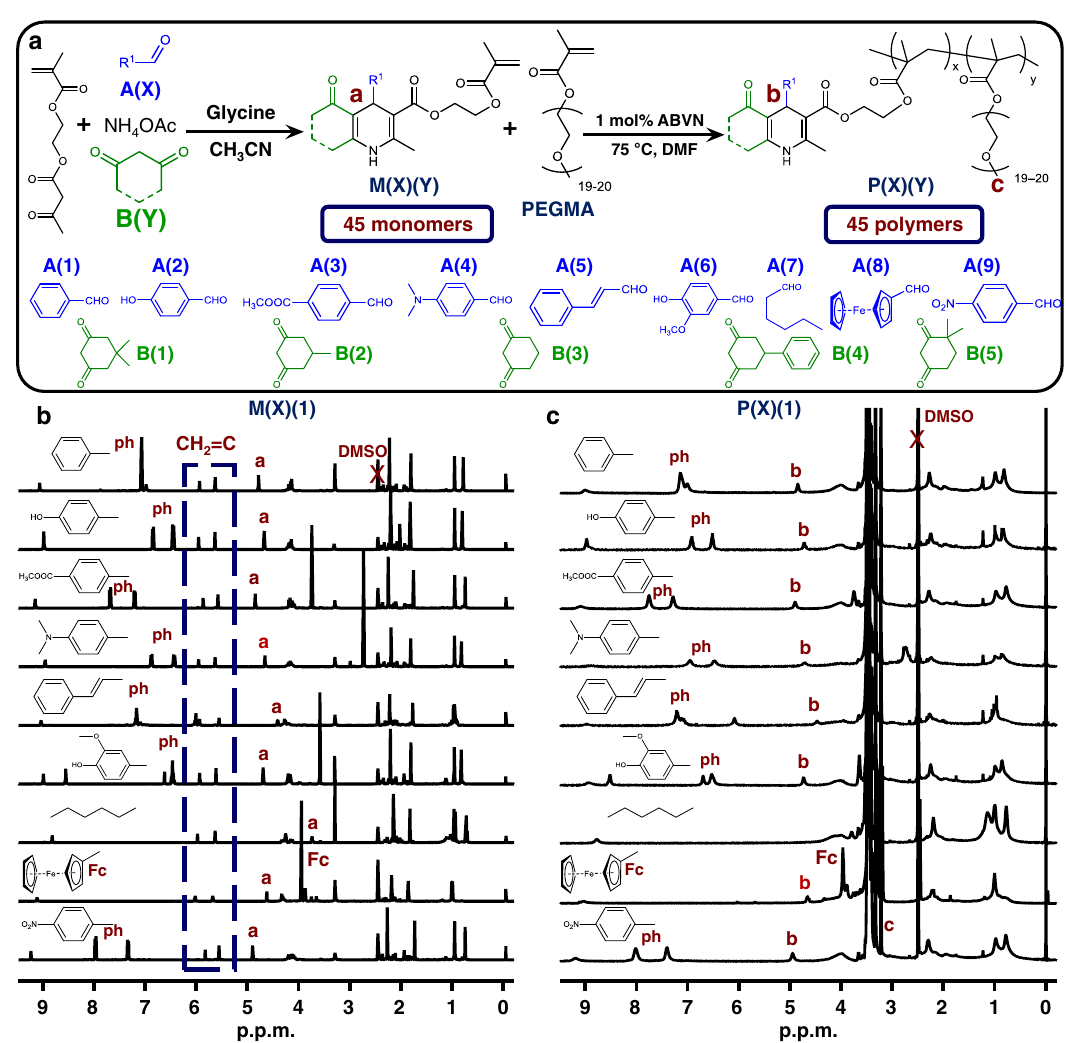
Fig. 2 The Hantzsch monomers and related polymers. a HTP preparation of 45 monomers via Hantzsch ’ s reaction and 45 polymers via free radical polymerization. b 1 H NMR spectra (DMSO- d 6 , 400 M) of M(X)(1) monomers. c 1 H NMR spectra (DMSO- d 6 , 400 M) of P(X)(1)